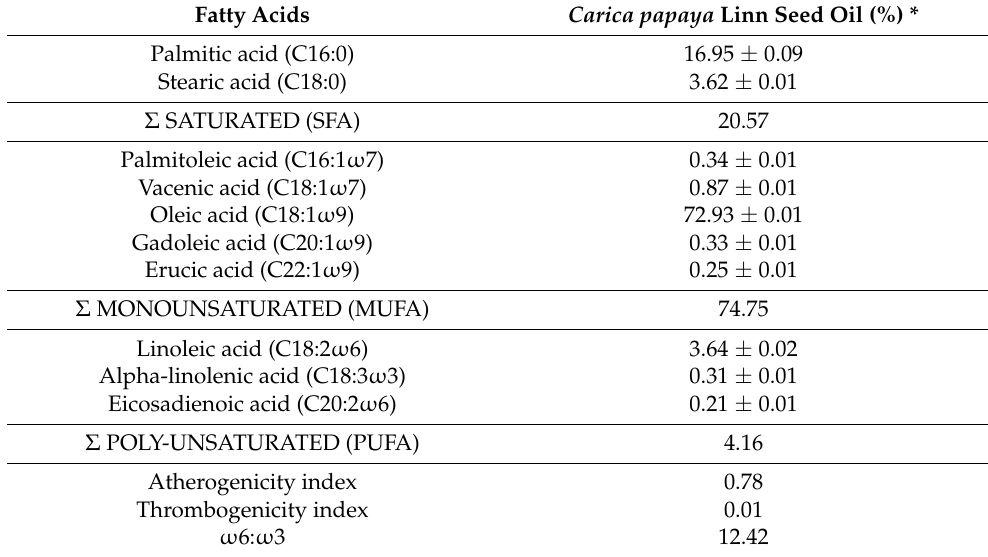
Table 1. Fatty acid composition of Carica papaya Linn seed oil.